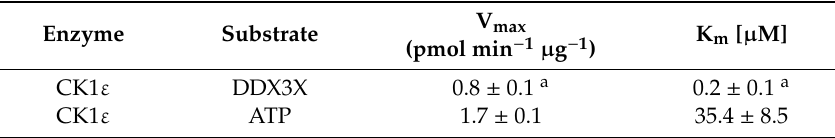
Figure 3. Kinetic set-up of CK1 ε towars DDX3X. ( A ) Substrate titration. A fixed amount of CK1 ε (25 ng) and ATP (30 µ M) were incubated with increasing concentrations of DDX3X (0.06–1 µ M) for 15 min. ( B ) ATP titration. A fixed amount of CK1 ε (25 ng) and DDX3X (0.48 µ M) were incubated with increasing concentrations of ATP (7.5–120 µ M) for 15 min. Bars indicate mean ± SD. Table 3. Kinetic parameters of CK1 ε towards DDX3X and